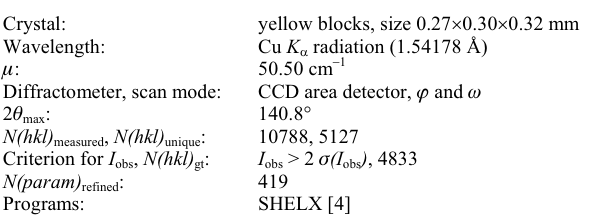
Table 1. Data collection and